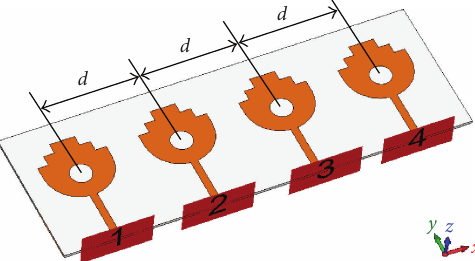
Figure 13: Four identical UWB antenna elements fed simultane- ously through four independent microstrip lines.